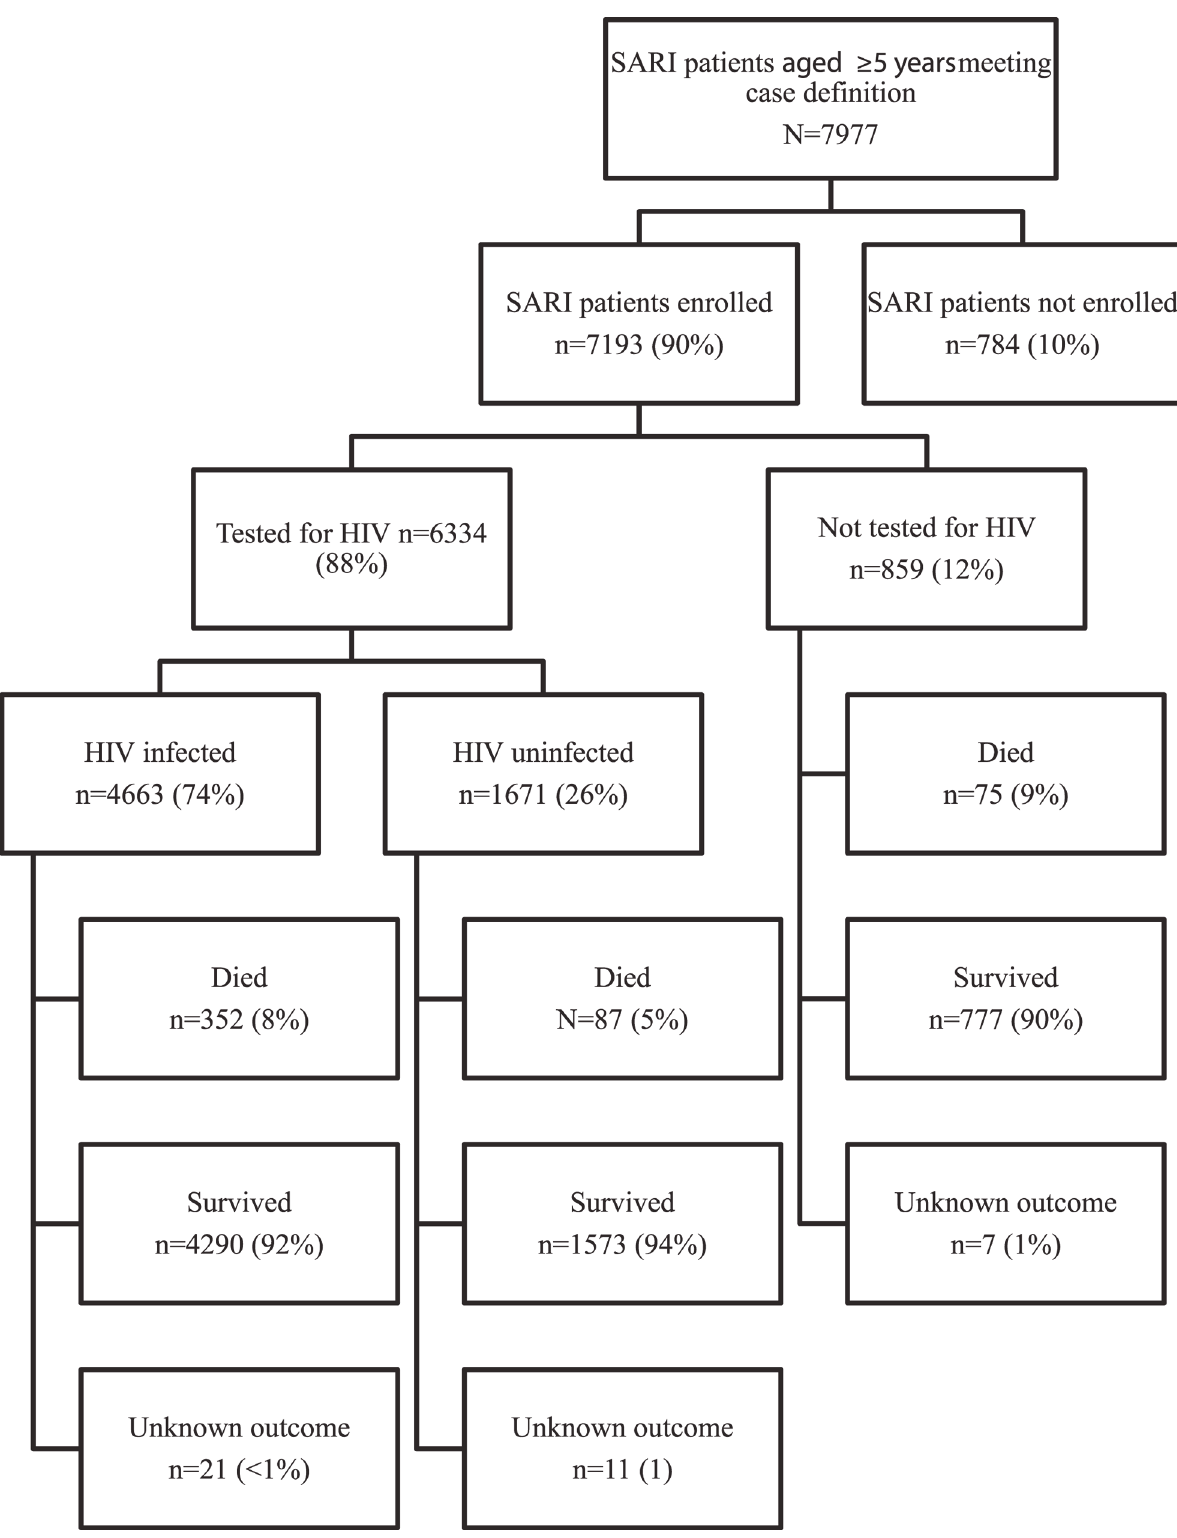
Fig 1. Flow chart of patients aged (cid:1) 5 years included in the study. SARI — severe acute respiratory illness, HIV — human immunodeficiency virus.